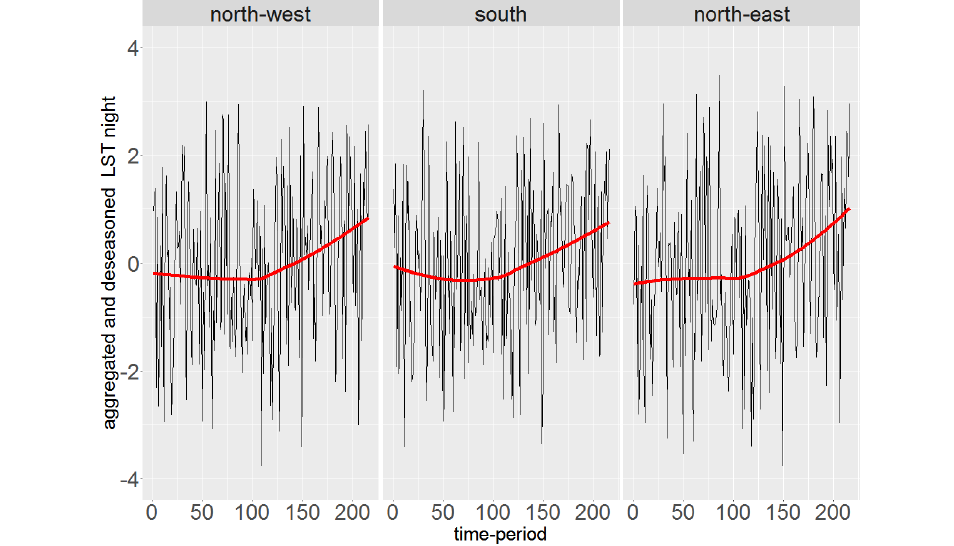
Figure 15. Average LST night, after aggregation and deseasoning, of the pixels detected by both Mann–Kendall and Strucchange methods, categorised in three areas together with their locally weighted smooth regression lines in